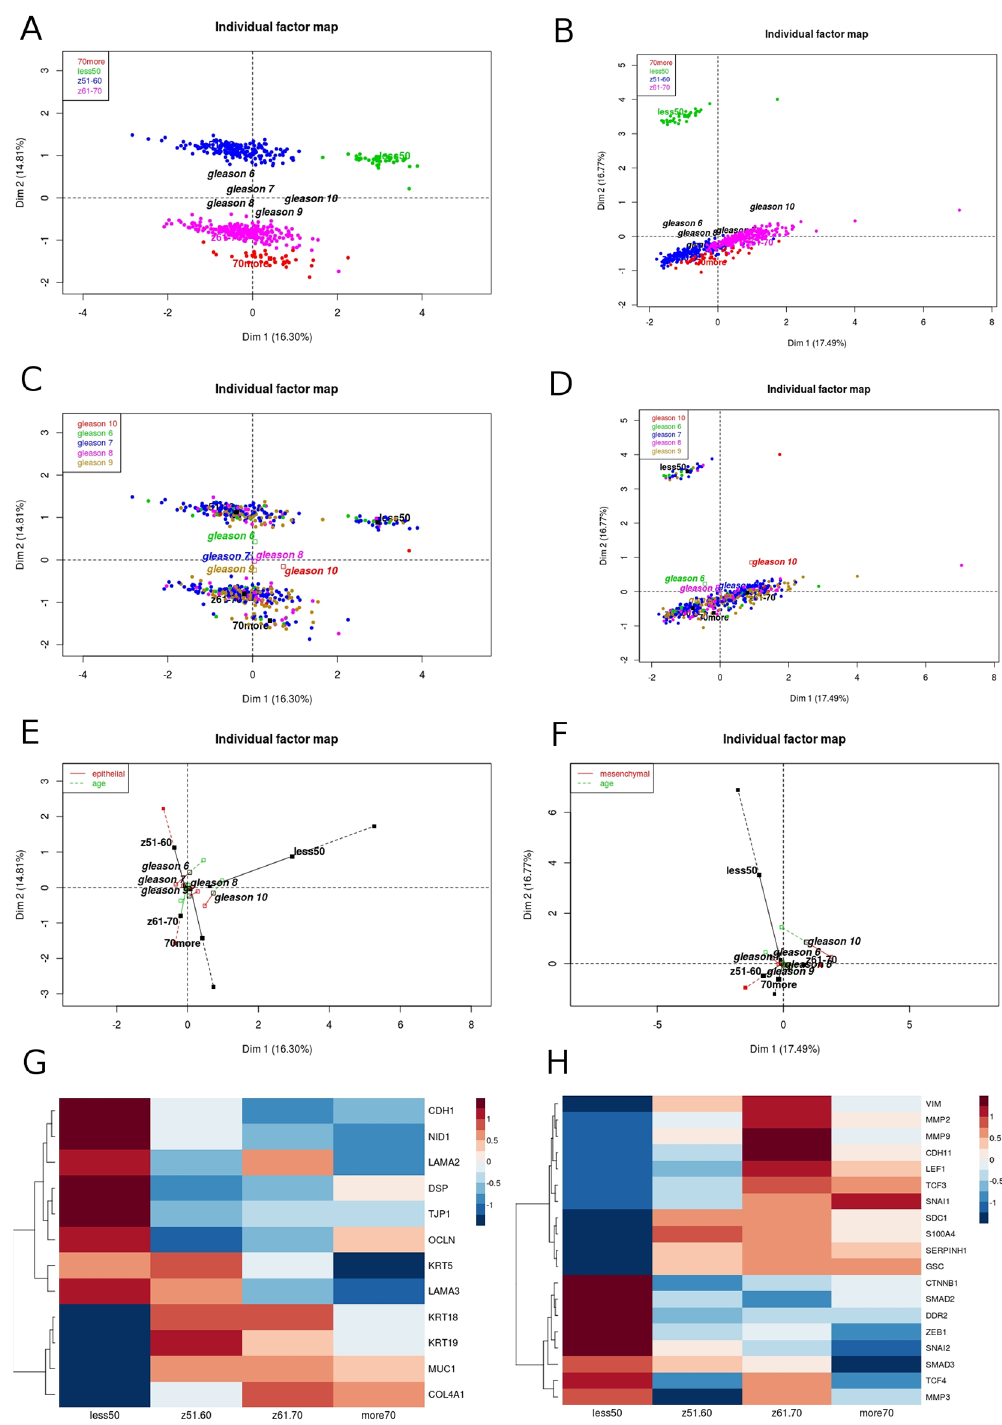
Fig 4. Prostate tumors diagnosed at age (cid:20) 50 and 70 > years old show shift in characteristics regarding expressionof the mostly differentiating epithelial vs mesenchymal state markers. The expressionof epithelial (A, C) vs mesenchymal (B, D) state markers in separate partitions PRAD patients oppositely. The projections representingcontribution of epithelial(E) and mesenchymal (F) state markers alongthe dimensions indicate significantshift in the EMT model in the age groups, especiallyin the youngestand the oldest males. In addition,the shift towards more aggressivemesenchymal character of the tumor is observable in the contrastingexpressionof particulargenesinvolvedin the EMT (G) epithelialstate markers, H) mesenchymal state markers).